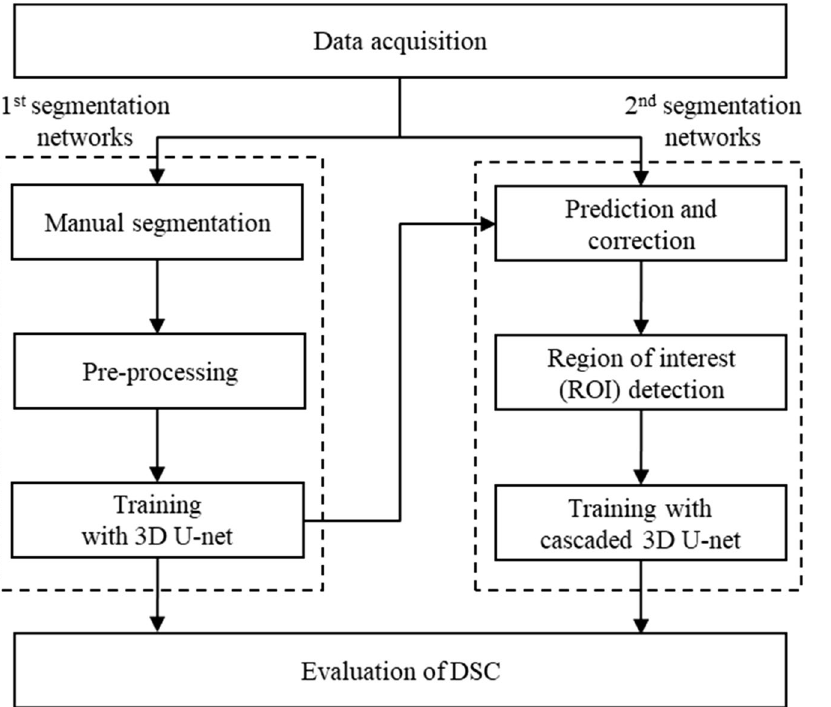
Figure 1. The overall procedures of a basic 3D U-Net and a cascaded 3D